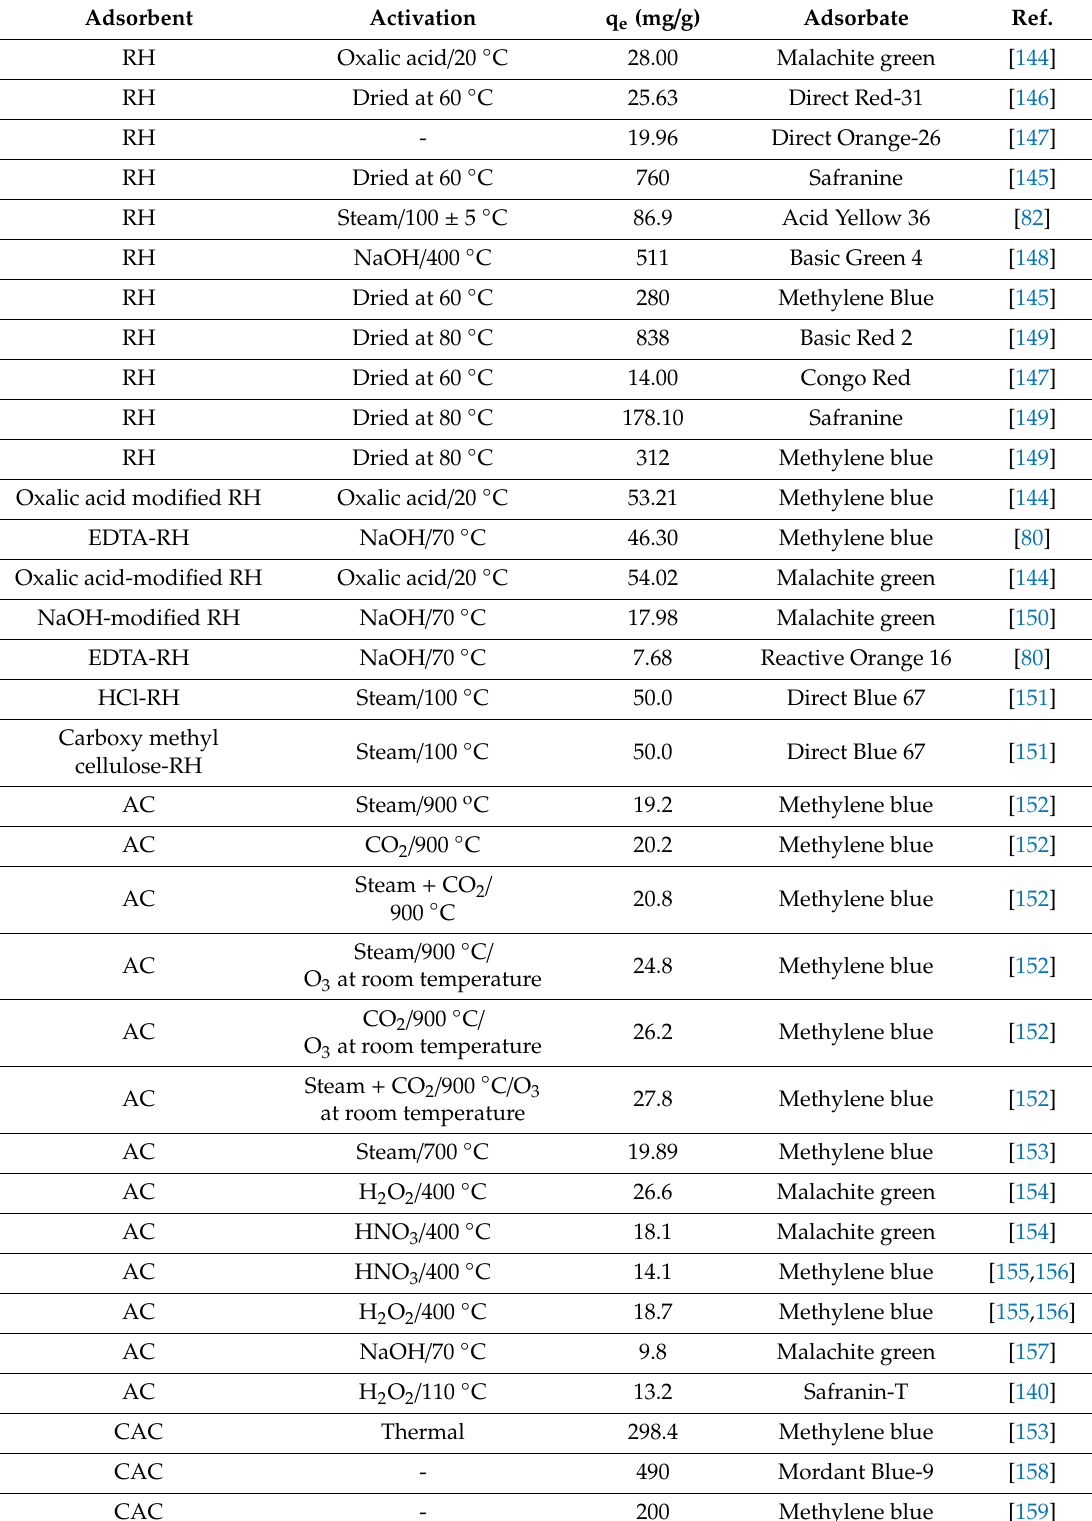
Table 6. Organic contaminant adsorption capacity by AC prepared from RH and pristine RH. CAC: commercial activated